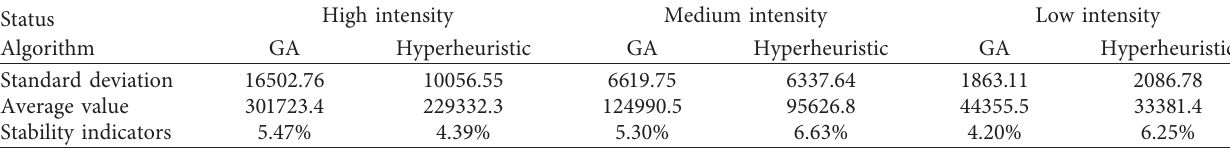
Table 2: Stability analysis table of GA and hyperheuristic algorithm under smooth passenger